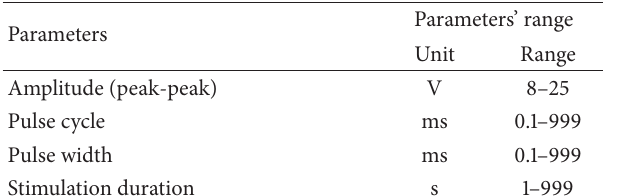
Table 1: Stimulation